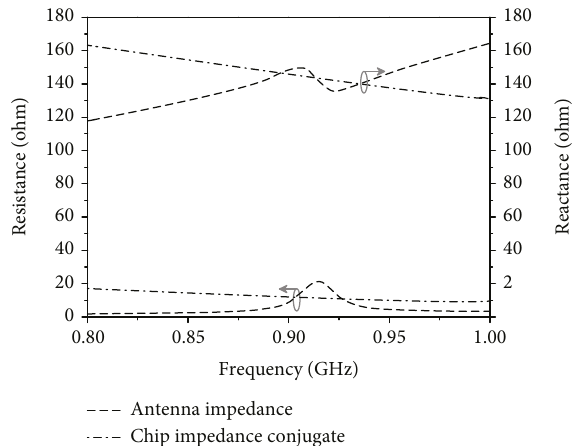
Figure 4: Impedance simulation of the antenna and the chip with the optimized parameters ( L = 78 mm, W = 30 mm, h = 3 mm, W = 8 2 mm, L = 47 2 mm, and W = 1 6 mm). loop loop gap